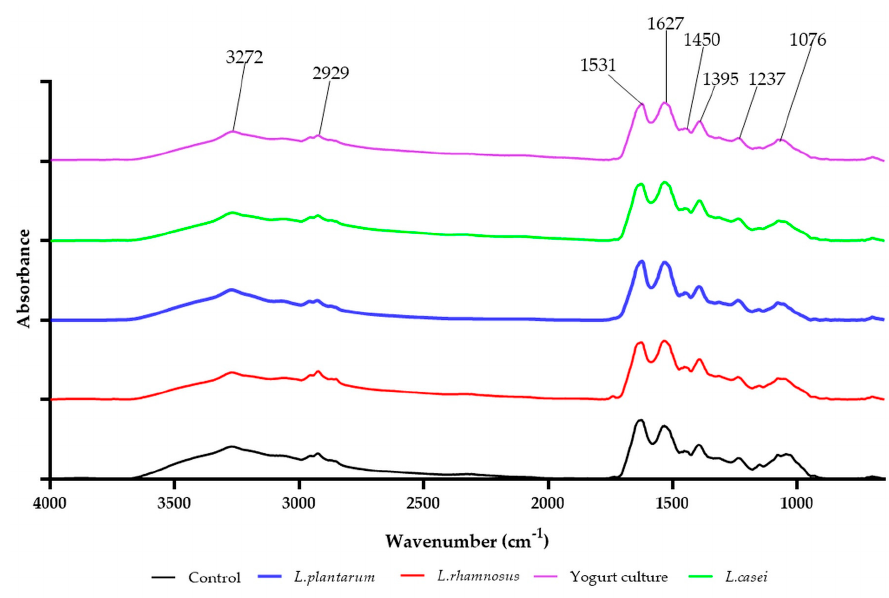
Figure 2. FTIR spectra of fermented F. limosus meat.